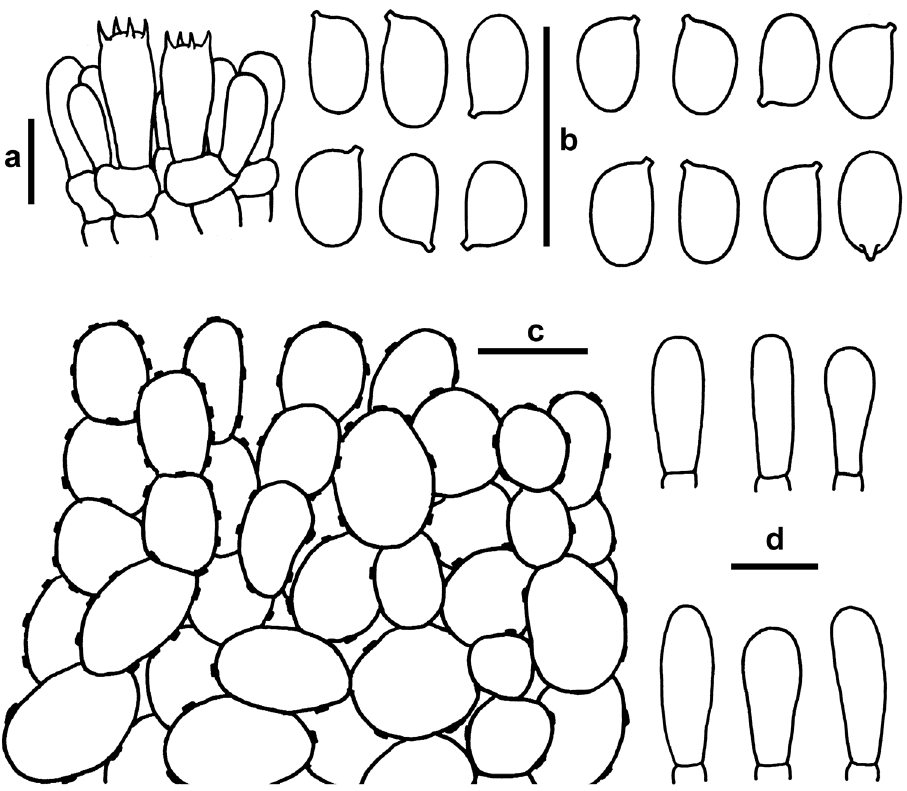
Figure 4. Microscopic features of Xanthagaricus necopinatus (GDGM 46632, holotype; PHI-12, iso- type). a Basidia with basidioles b Basidiospores c Epithelial pileipellis with encrusted wall d Cheilocyst- idia. Scale bars: 10